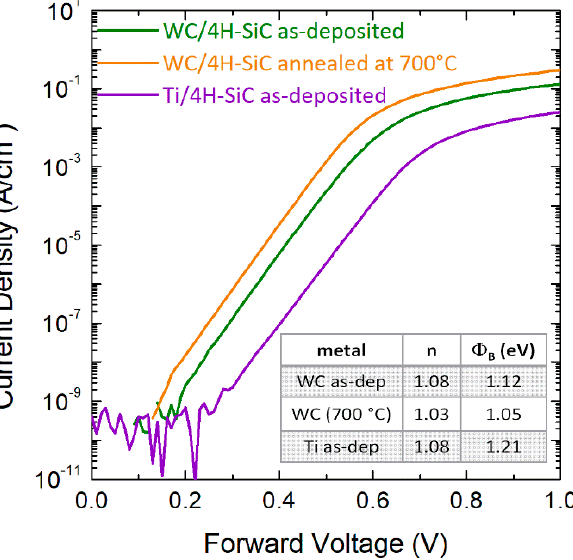
Figure 9. Representative forward I–V characteristics of WC/4H-SiC Schottky diodes for the as- deposited contact and after thermal annealing at 700 ◦ C. The I–V characteristic of a reference Ti/4H- SiC is also reported for comparison. The data are taken from Refs.